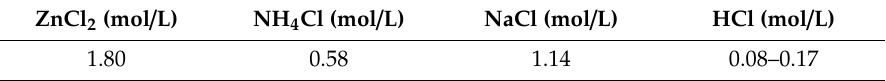
Table 3. Molar concentration of each component in accelerant